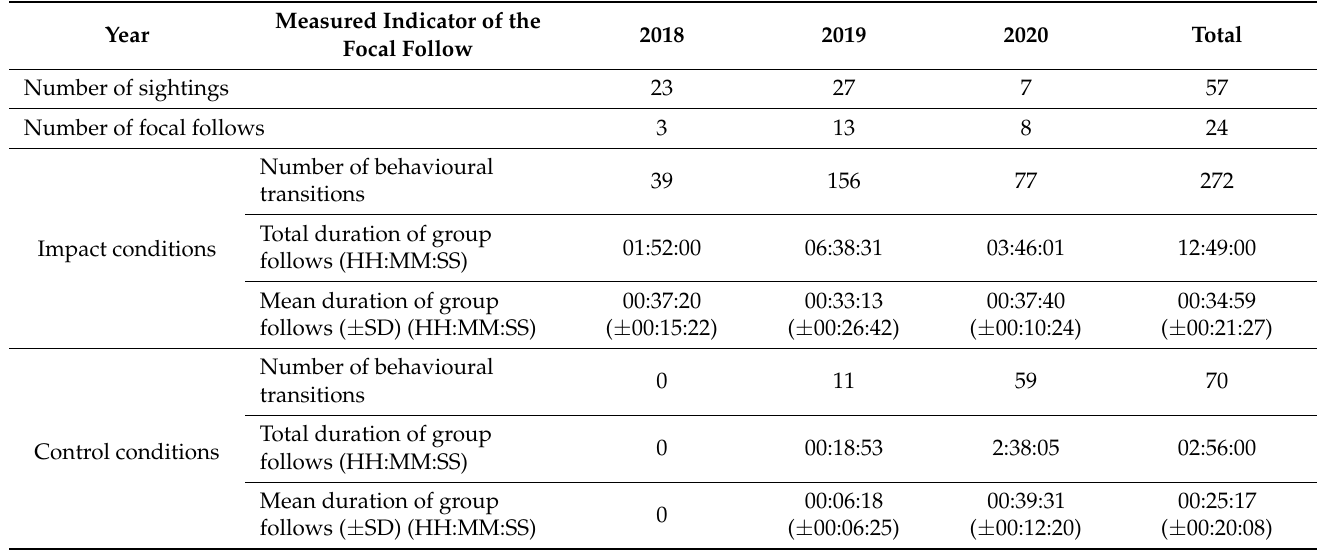
Table 2. Details on the focal follows carried out between February 2018 and June 2020 on spinner dolphin groups. Measured Indicator of the Year Focal